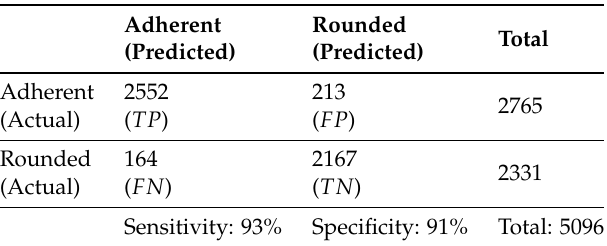
Table 2. List of parameters evaluated by the proposed method. FN: false negative; FP: false positive; TN: true negative; TP: true